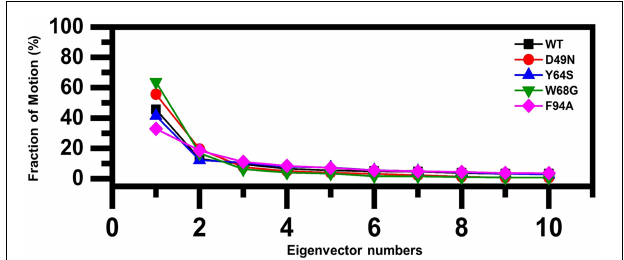
FIGURE 5 | Fractions of the first ten eigenvectors. Using the MD trajectory, the fraction of motions is calculated and given in percentage against the eigenvector